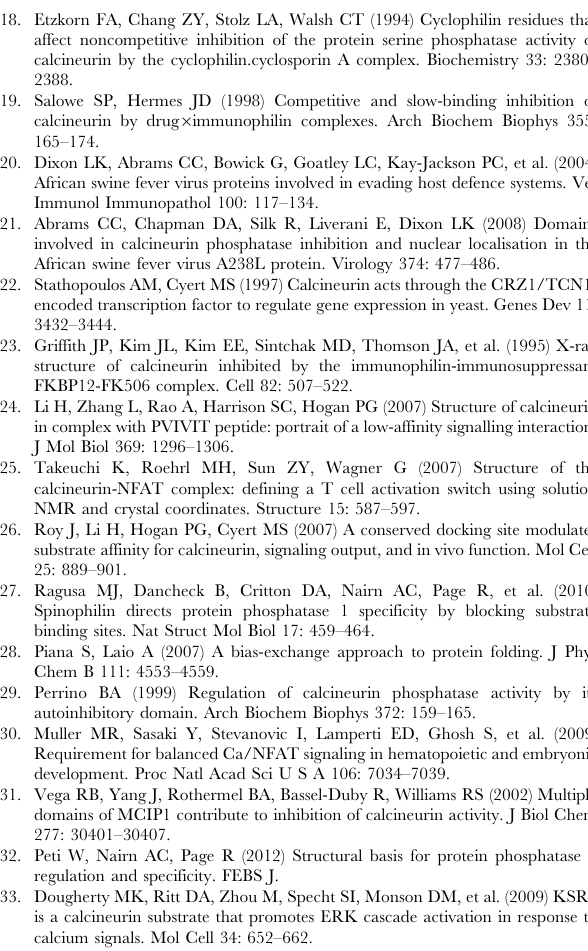
Figure S5 Stereoview of the A238L electron density. (A) Sigma 2m F o -D F c electron density map of A238L contoured at 1 s to 1.70 A˚ (blue mesh). A238L shown as magenta sticks with the PxIxIT and LxVP motifs in green. (B) Close-up stereoview of the A238L LxVP motif, with LxVP residues